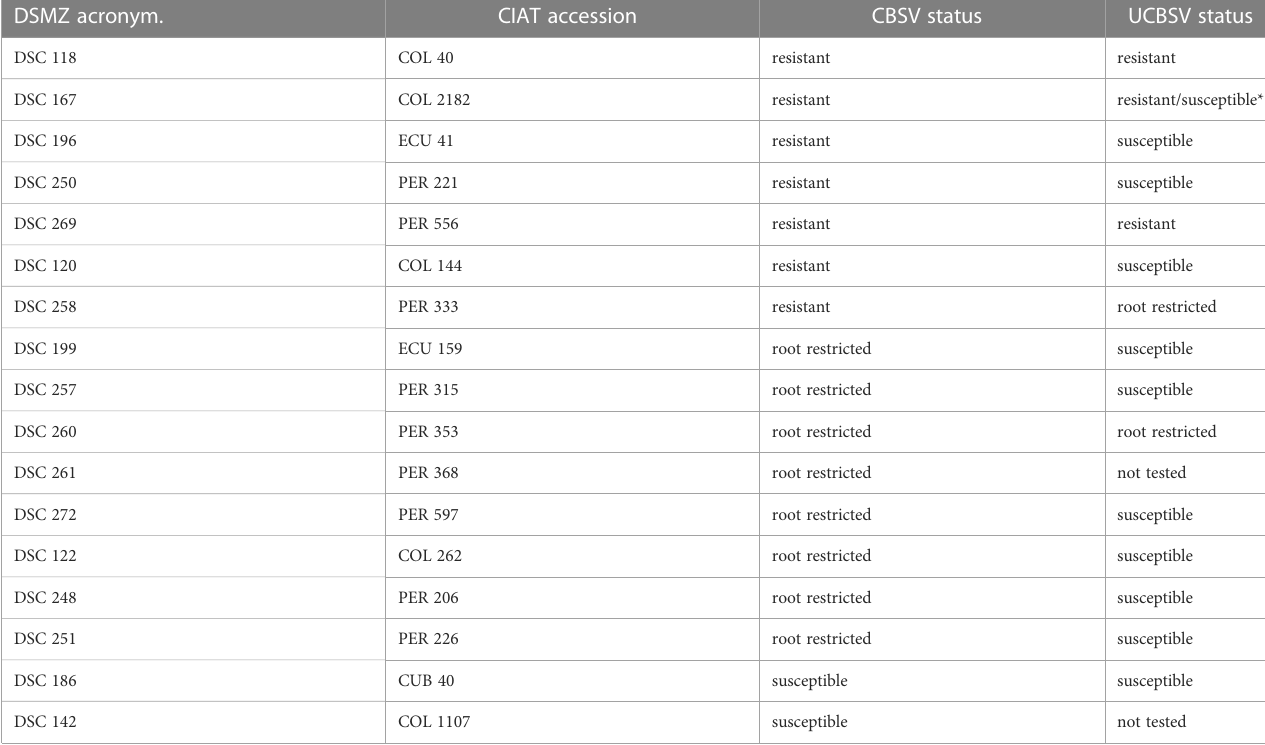
TABLE 2 Cassava germplasm from South America with resistance against cassava brown streak viruses. DSMZ acronym.